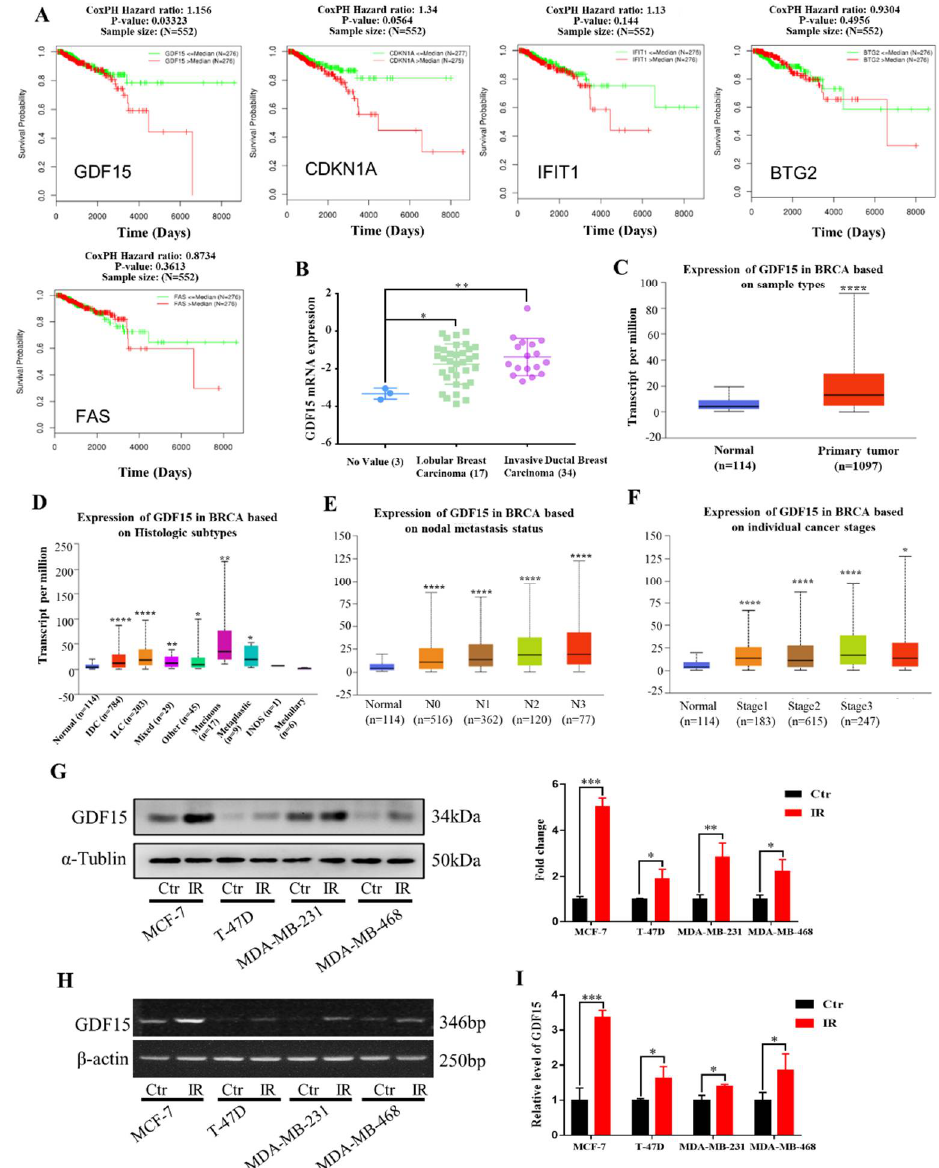
Figure 3. Expressions of 5 DEGs in the clinical samples of breast cancer patients and the GDF15 expressions in different breast cancer cells. ( A ) Relationship of the expression levels of DEGs (GDF15, IFIT1, CDKN1A, FAS, BTG2) and the survival of 552 breast cancer patients in the LinkedOmics database. ( B ) The mRNA level of GDF15 in lobular breast carcinoma and invasive ductal breast carcinoma was higher than that in normal tissues. Data were obtained from Oncomine database. ( C ) GDF15 mRNA was highly up-regulated in breast cancer samples in comparison with normal breast samples. ( D ) The expression of GDF15 in different histologic subtypes of breast cancer was higher than that in normal breast tissue. ( E , F ) The elevated GDF15 was significantly correlated with nodal metastasis status and individual cancer stages of breast cancer. ( G ) Western blot assay of the GDF15 protein expression in MCF-7, T-47D, MDA-MB-231 and MDA-MB-468 cells irradiated with 5 Gy X-rays or sham-irradiated. ( H , I ) RT-PCR and qRT-PCR assay of GDF15 mRNA expression in above cells. **** p < 0.0001, *** p < 0.001, ** p < 0.01, * p < 0.05.